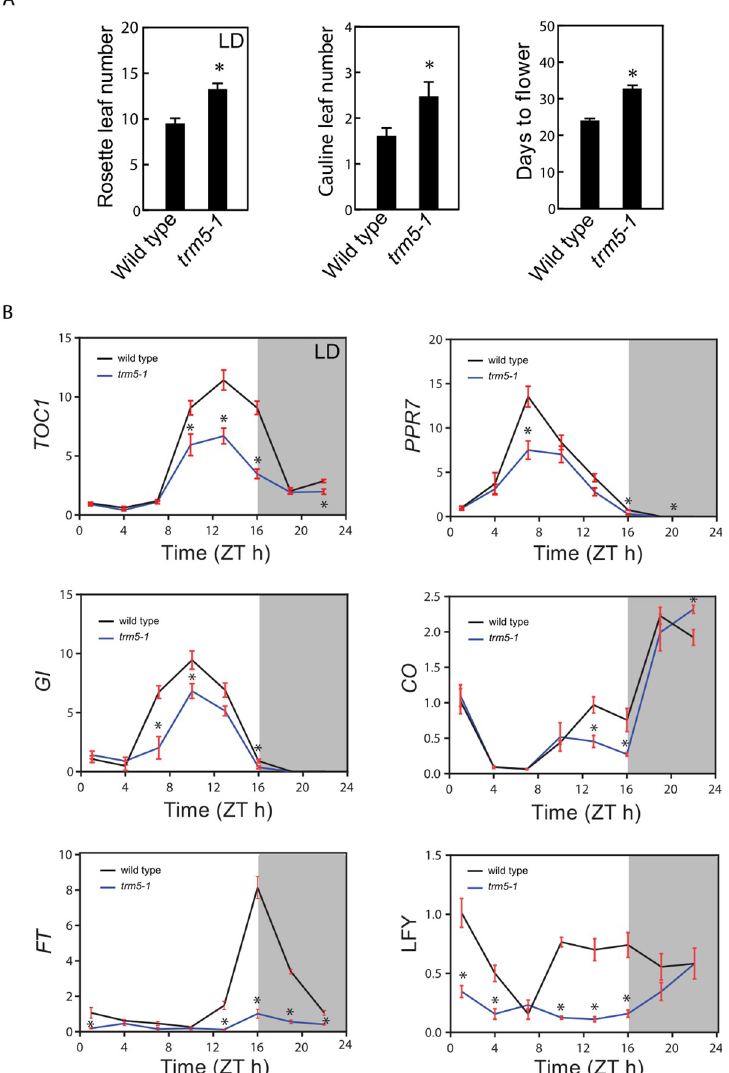
Fig 3. More leaves, slower flowering and impacted photosynthetic genes in trm5 mutant of Arabidopsis thaliana . ( A ) Rosette leaf number (long-day conditions), cauline leaf number and days to flower (short day conditions) of wild type and trm5 mutant. ( B ) The mRNA abundance of circadian clock-related genes over a 24-hour period. 17-day-old seedlings of wild type, trm5-1 , complemented lines (35S:TRM5 trm5-1 ), TRM5 overexpression lines (35S:TRM5) were grown on ½ MS medium for 10 days and then harvested every 3 hours. The expression levels of TOC1 , PRR7 , GI, CO, FT , and LFY were measured and normalized relative to EF-1- α . Data presented are means. Error bars are ± SE, n = 3 biological replicates. An asterisk indicates a statistical difference ( P < 0.05) as determined by Student’s t-test. 0 hours is lights on and 16 hours is light off. Shaded area indicates night, whereas Zeitgeber time is abbreviated as